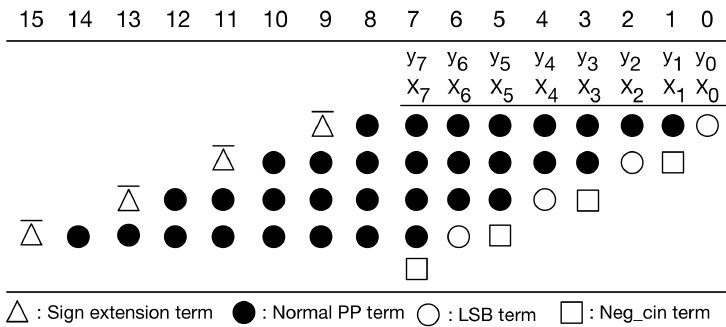
Figure 13. The PPM of each multiplication (in the first pipeline